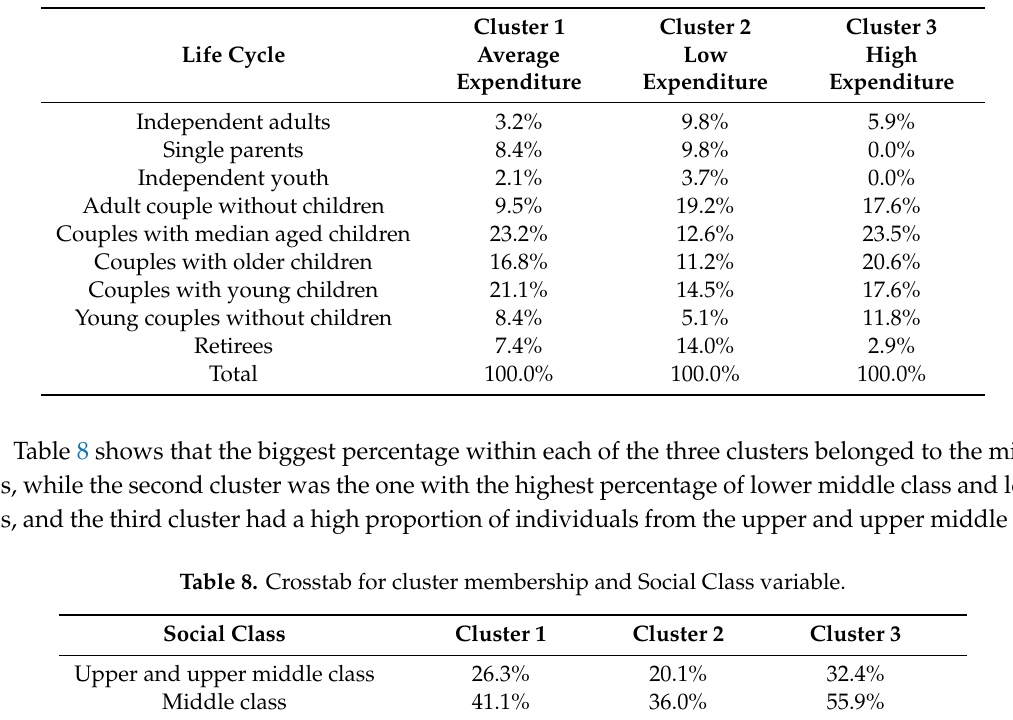
Table 7. Crosstab for cluster membership and life cycle variable.